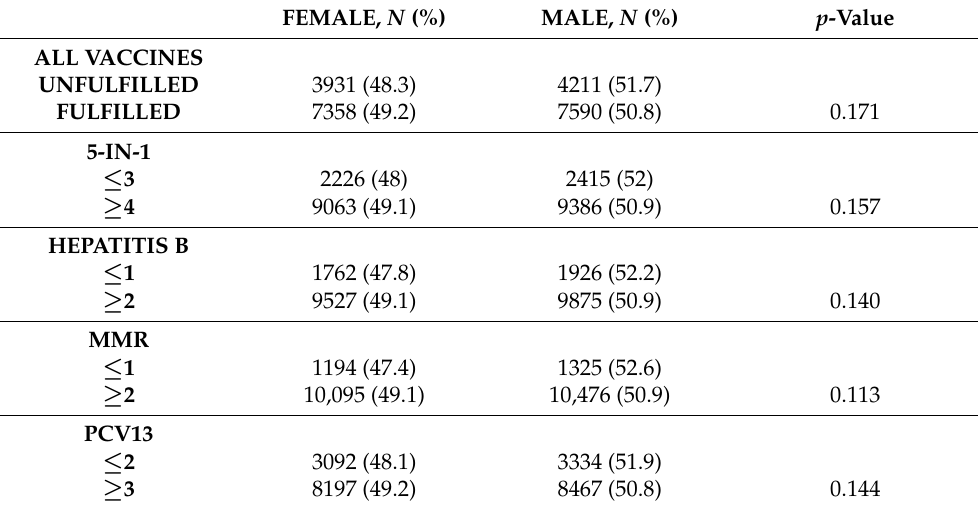
Table 4. Vaccination uptake rates between male and female participants for each individual